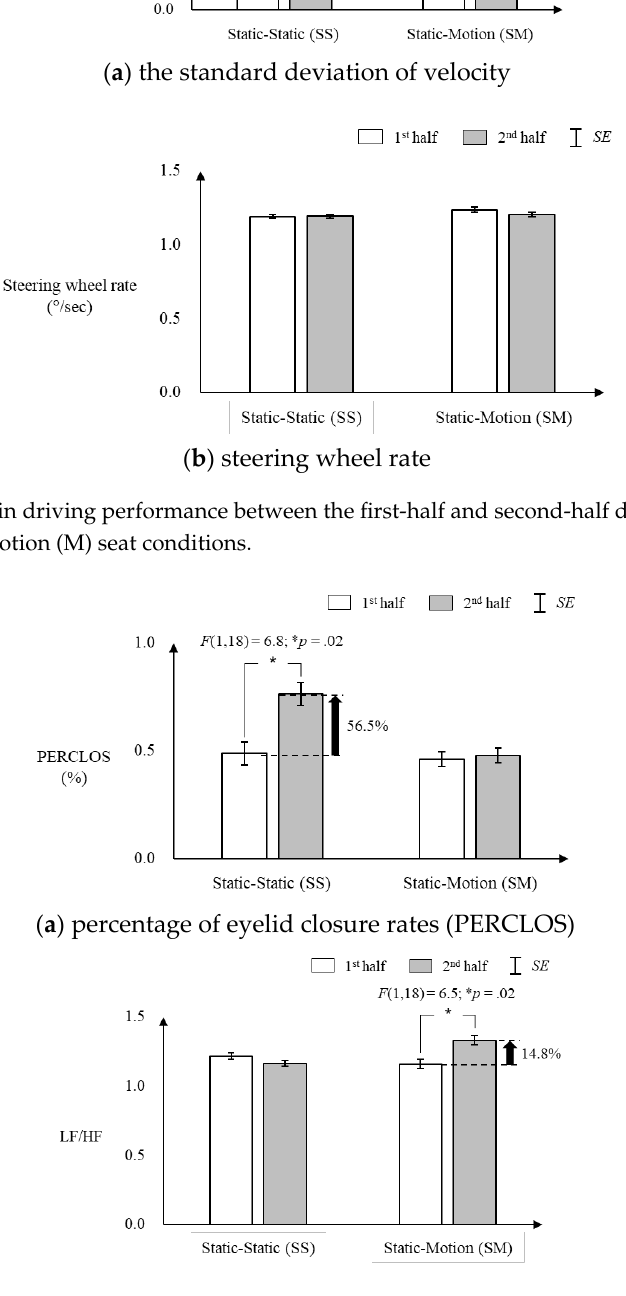
Figure 5. Changes in physiological responses between the first-half and second-half driving sessions for the static (S) and motion (M) seat conditions.